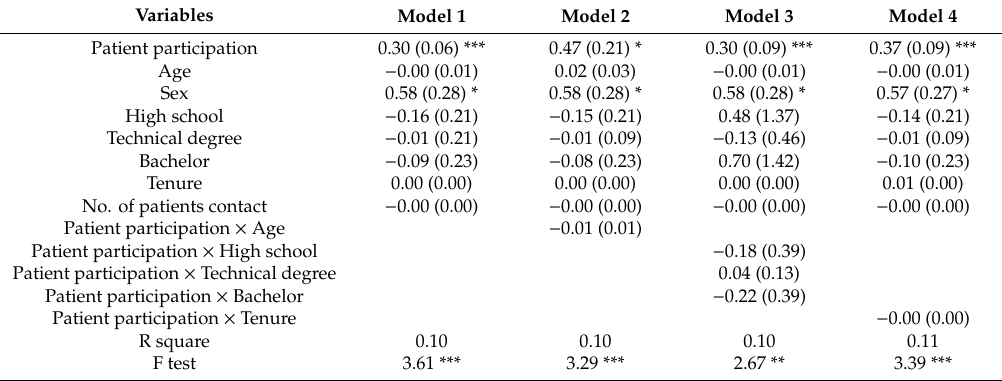
Table 6. Interaction between patient participation and nurse sociodemographic on work